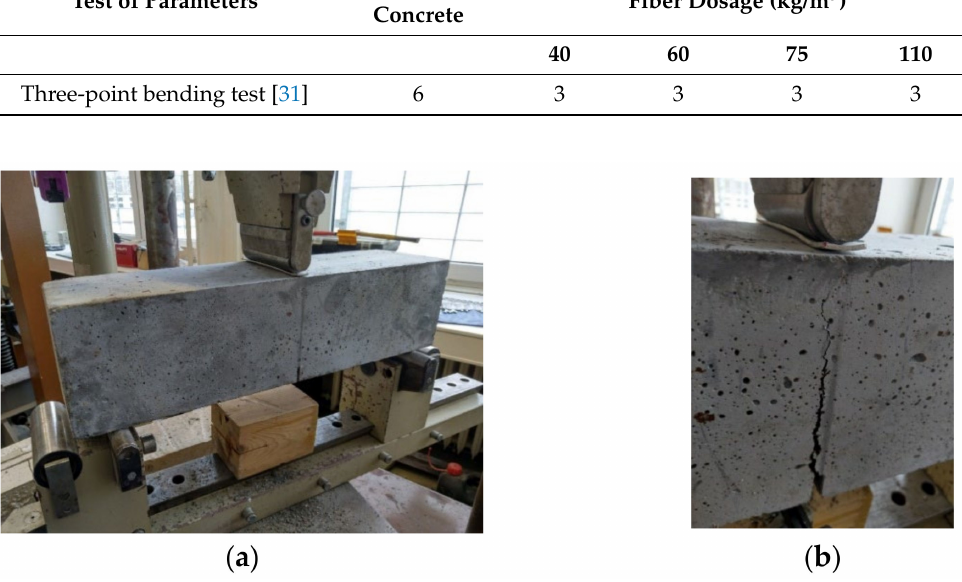
Figure 6. ( a ) Three-point bending test, ( b ) a crack in the